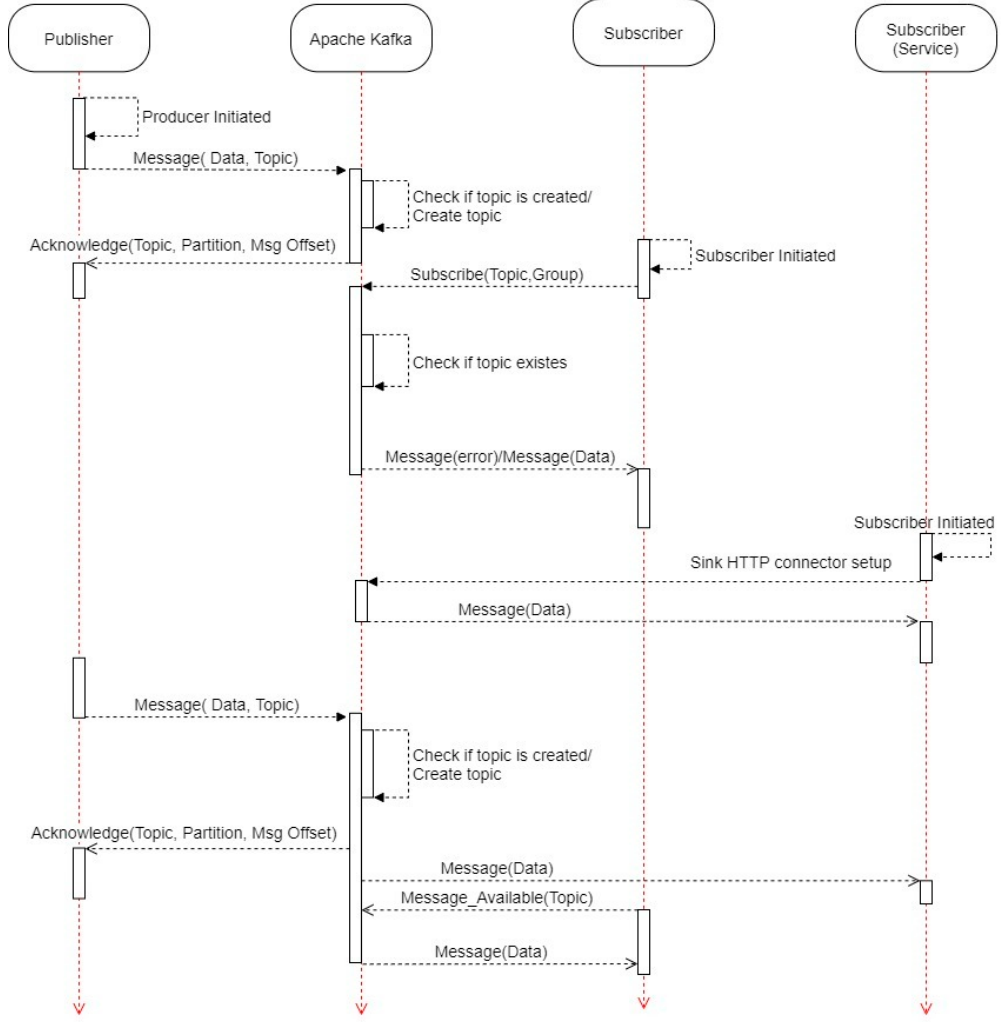
Figure 3. Sequence Diagram.